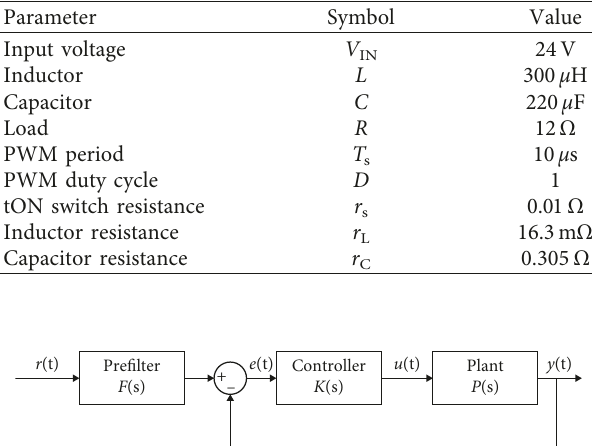
Table 1: Values of the elements used in the DC-DC buck convertor.